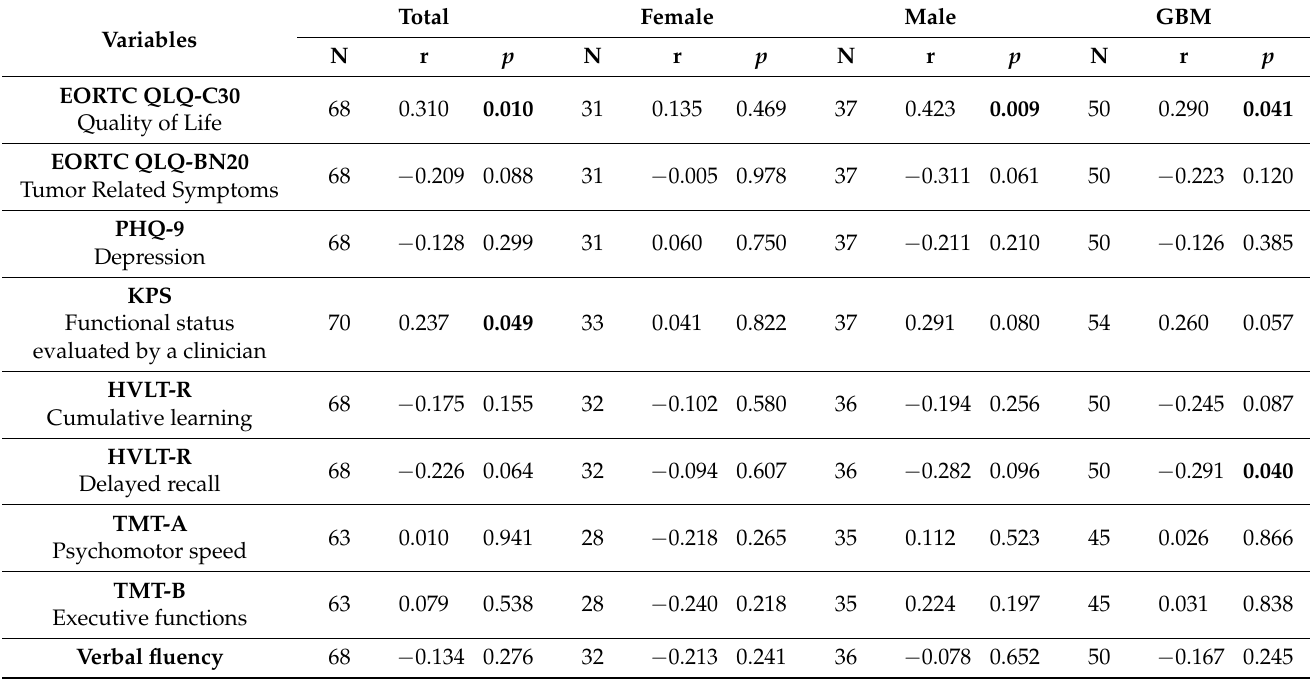
Table 3. Relationship between health-related quality of life indicators, clinical evaluation of patient’s functioning, and expression of miR-181a in different malignancy grade glioma